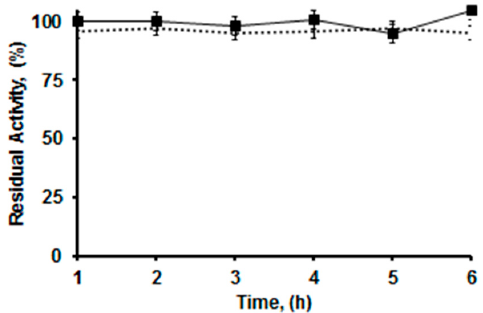
Figure 9. Reuses of OCEDA-CALB in the production of 1,2-diacetin by hydrolysis of triacetin. The experimental conditions are described in Methods section. Solid lane: relative activity (initial activity was taken as 100). Dashed line: 1,2-diacetin yield.